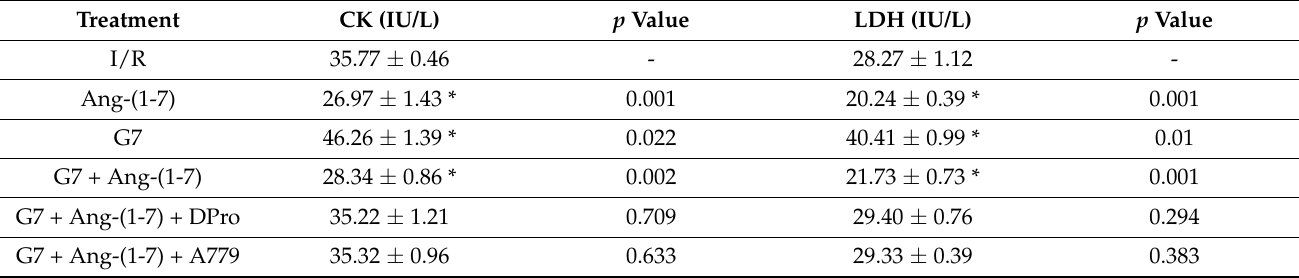
Table 2. Effects of Ang-(1-7) and its Mas receptor antagonists, ischemia/reperfusion (I/R) and cationic G7 PAMAM dendrimer on cardiac enzymes levels. CK = Creatinine kinase; LDH = lactate dehydrogenase. G7: seventh generation cationic PAMAM dendrimer; Ang-(1-7): angiotensin-1-7; D-Pro and A779 are Ang-(1-7) selective antagonists. Asterix * refers to significant difference ( p < 0.05) compared to control I/R